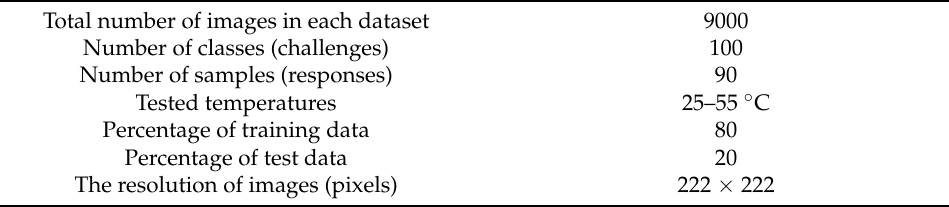
Table 4. The specifics about the generated